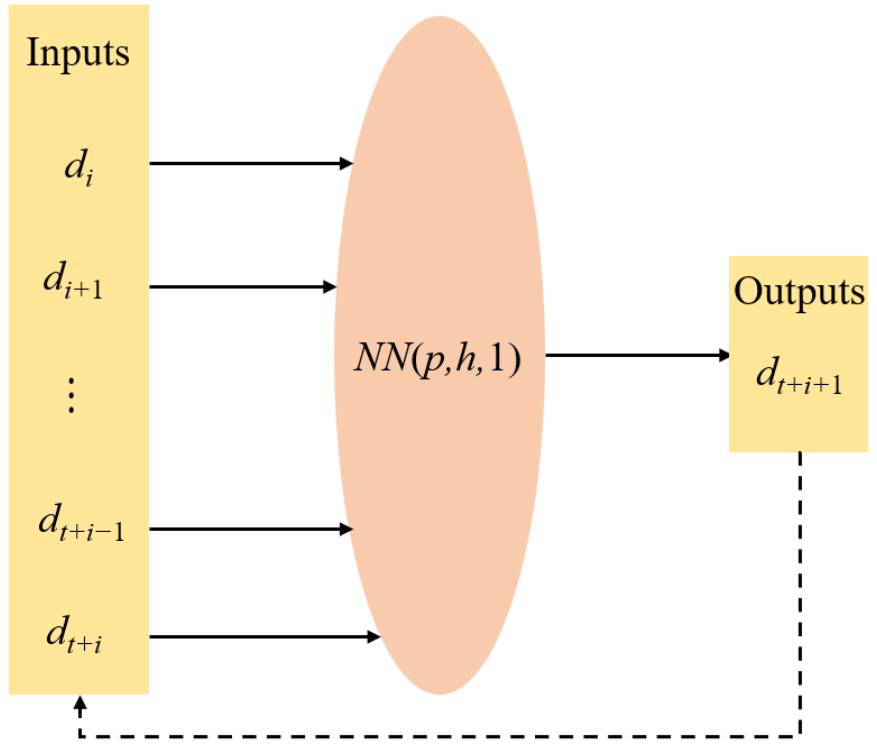
Figure 3. Intelligent prediction of neural network in tunnel surrounding rock deformation.